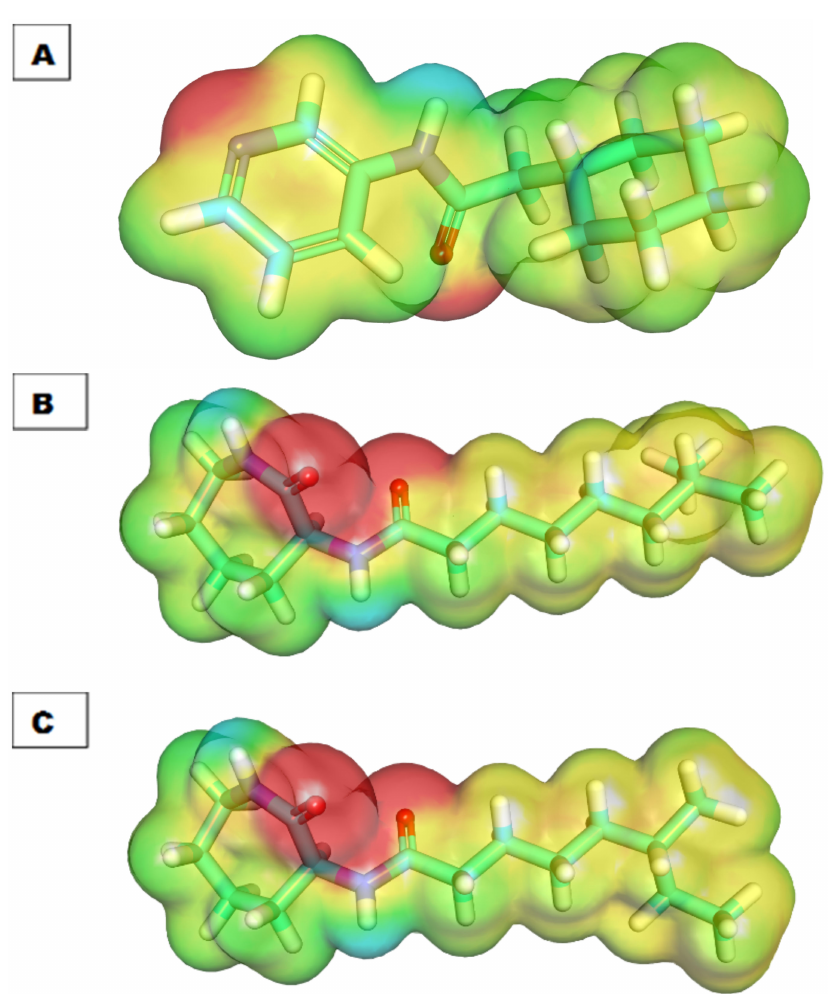
Figure 9. Molecular electrostatic potential map of ( A ) GWS , ( B ) metabolite 292 , and ( C ) metabolite 293 . Valuable insight can be gained about the binding pattern with the receptor from molecular orbital and electrostatic potential map analyses (Figures 8 and 9). The HOMO of GWS was concentrated on a pyridine moiety and the C=O group of the amide linker (two red patches). These functional groups formed two hydrogen-bond acceptors with His163 and Glu166. The LUMO of GWS was concentrated in the NH group of amide the linker (blue patch), which formed a hydrogen bond donor with Asn142. In addition, the pyridine and cyclohexyl rings have a high electron density (green to yellow), which can favor the hydrophobic and π -staking interactions withLeu141, Glu166, Met49, Arg188, and His41.For compound 292 , the HOMO was concentrated on the two C=O groups (two red patches), forming two hydrogen-bond acceptors with Gly143 and His163, whereas the LUMO was concentrated on the two NH groups (two blue patches), forming two hydrogen-bond donors with His172 and Glu166. Regarding compound 293 , the HOMO was concentrated on the two C=O groups (two red patches), forming two hydrogen-bond acceptors with Glu166 and His163, whereas the LUMO was concentrated on the two NH groups (two blue patches), forming three hydrogen-bond donors with Phe140, Asn142, and Glu166. The aliphatic chains in each molecule showed yellow patches that can form hydrophobic interactions with hydrophobic amino acid residues (Figure 9). Subsequently, metabolites 292 and 293 were identified as having the same probabilities in DFT studies. Although metabolites 292 and 293 had the same probabilities in the DFT studies, 292 was selected for the next study, as it had higher binding energy in the docking